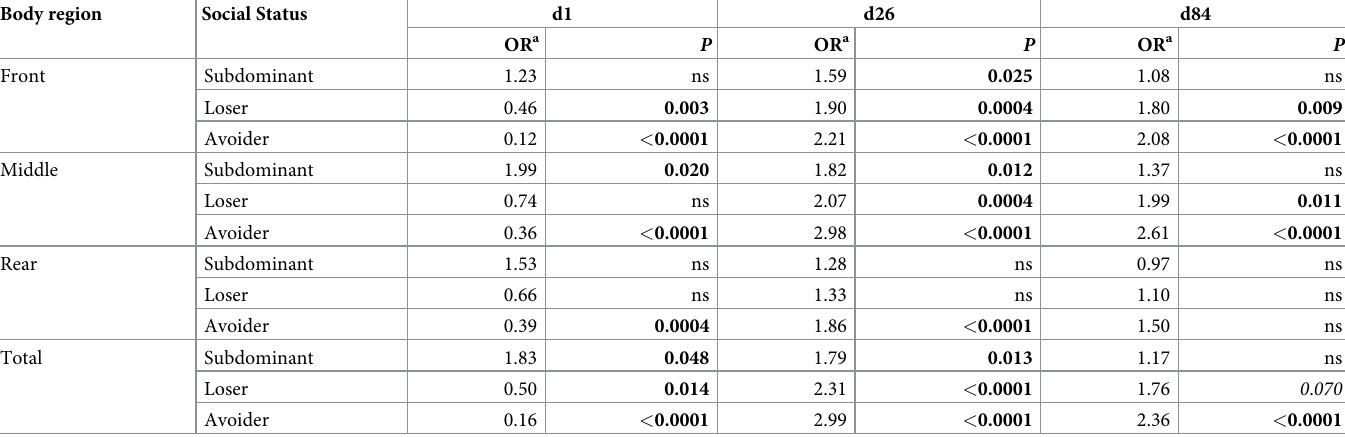
a The reference level is the Dominant status thus odd ratios higher than 1.00 indicate that lesion scores of sows from other social status (i.e., Subdominant, Loser or Avoider) are higher than lesion scores of